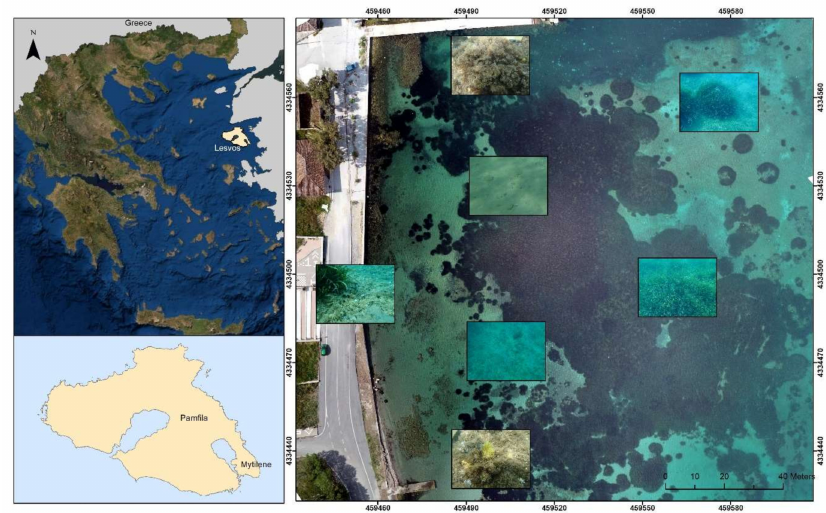
Figure 1. Location of the study area in Lesvos Island, Greece ( left ). The underwater images of the marine habitats in the area placed on the orthophoto-map ( right